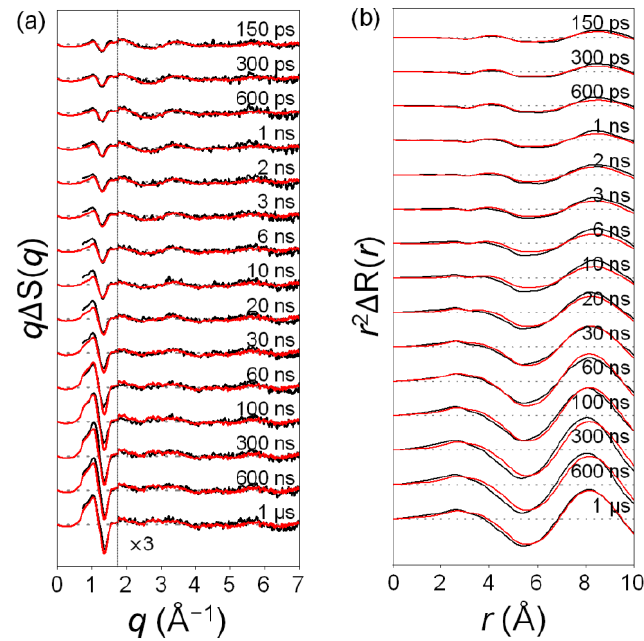
Figure 1. ( a ) Time-resolved difference scattering curves q ΔS( q , t ) for C 2 F 4 I 2 in cyclohexane as a function of time delay after photoexcitation at 267 nm. Experimental curves (black), q ΔS( q , t ) = q S( q , t ) − q S( q , −200 ps) are compared with calculated curves (red) obtained from global-fit analysis. Data at high q values (1.8 ~ 7.5 Å –1 ) were scaled up by a factor of three for better visualization. ( b ) Difference radial distribution functions (ΔRDFs), r 2 ΔR( r , t ), obtained by the sine Fourier transformation of q ΔS( q ) curves shown in ( a ).